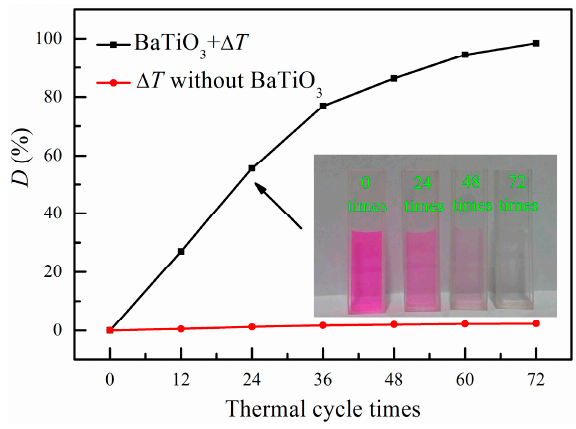
Figure 6. The decomposition efficiency of RhB with or without BaTiO 3 nanofibers. The inset is the degradation photograph.